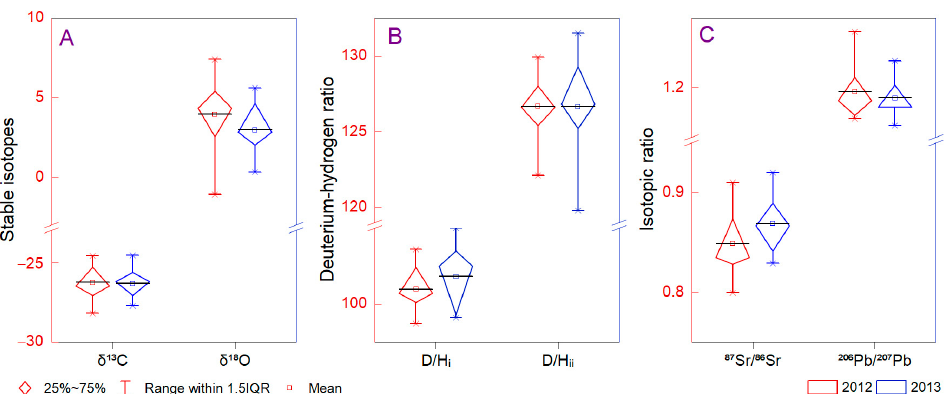
Figure 3. The distribution of stable isotopes ( A ), the deuterium–hydrogen ratio ( B ), and the isotopic ratio ( C ) of wine capitalized in 2012 and 2013 in Transylvania and Muntenia. Comparatively, the values from 2012 (red) and 2013 (blue) are illustrated.